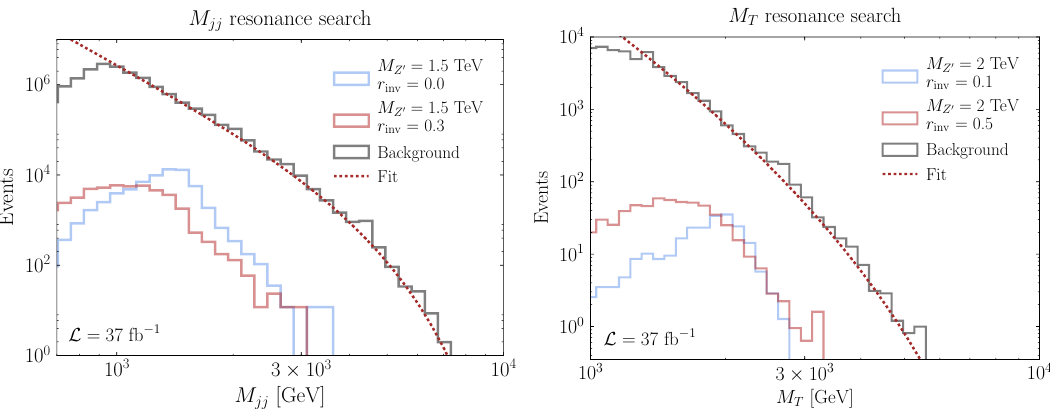
Figure 8 . (Left) Invariant mass distribution for the dedicated s -channel search. The background distribution is shown in black, while benchmark signal distributions are shown for M Z 0 = 1 : 5 TeV and r inv = 0 : 0 and 0 : 3 in blue and red, respectively. (Right) The transverse mass distribution, this time for M Z 0 = 2 TeV and r inv = 0 : 1 and 0 : 5 in blue and red, respectively. For each panel, the background (cid:12)t used in that analysis is shown in dotted red. In both cases, the signal is plotted assuming g q = 0 : 1 and g (cid:31) =